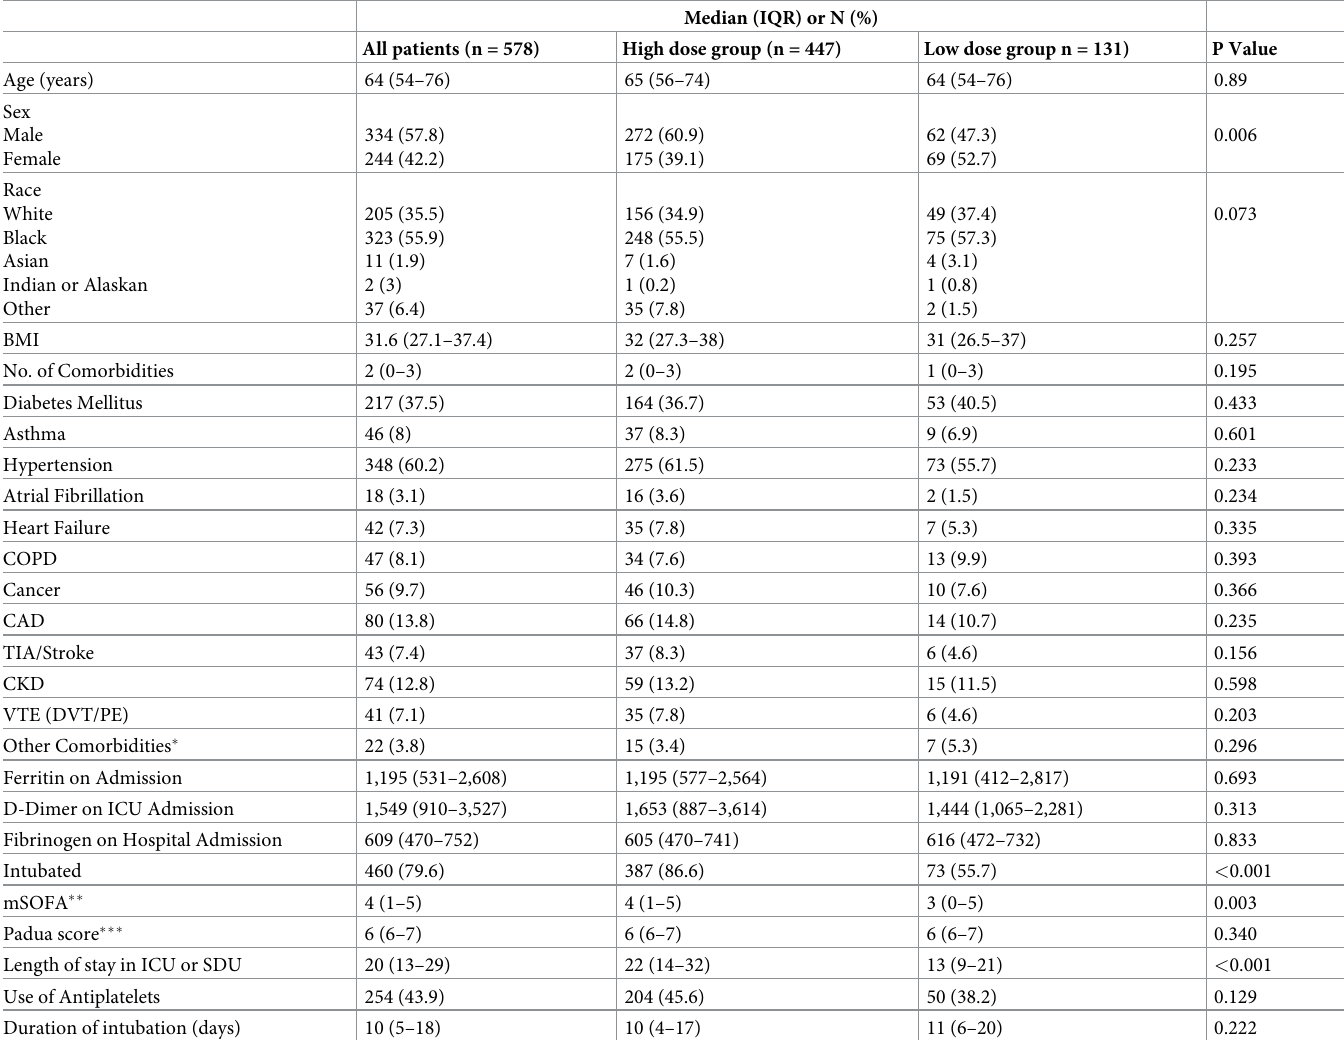
Table 1. Baseline characteristics of